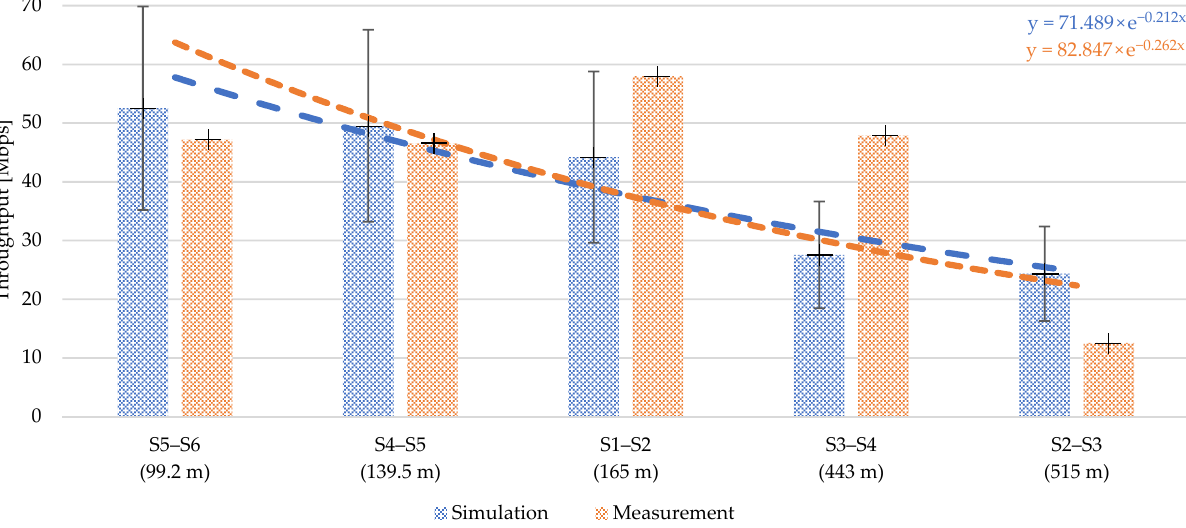
Figure 12. Comparison of simulated and measured results: (Simulation) NS-3 simulation of real topology with PLC model setup due to BPLC modems parameters; (Measurement) Throughput measurement on UDP layer in one direction in sub-sections—without repeaters.